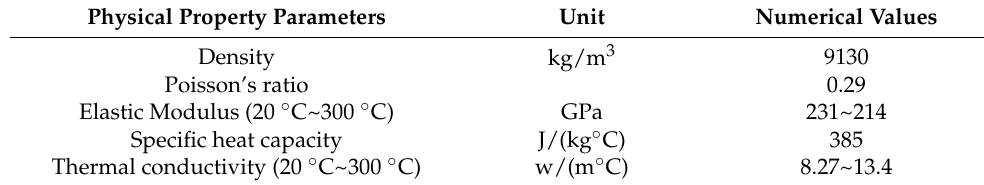
Table 1. Physical properties of brush filament materials.